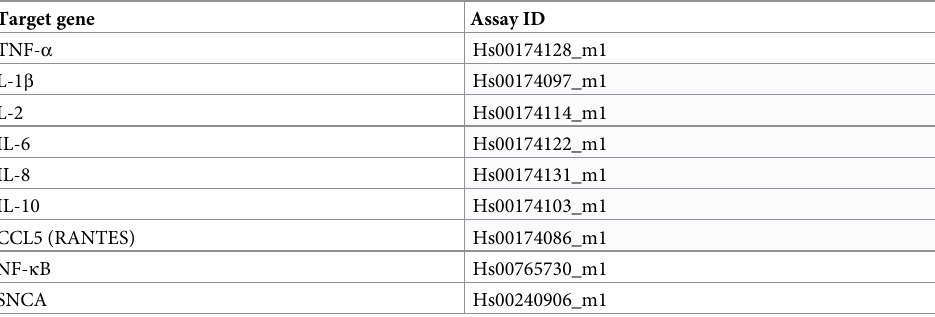
Table 2. List of primers used for qRT-PCR